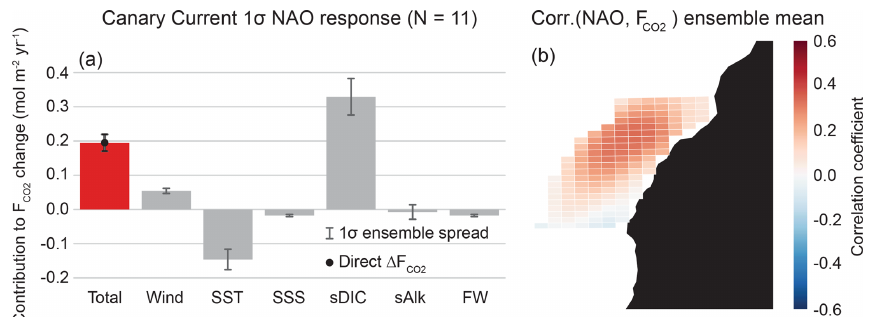
Figure 9. As in Fig. 6, but for the Canary Current response to the